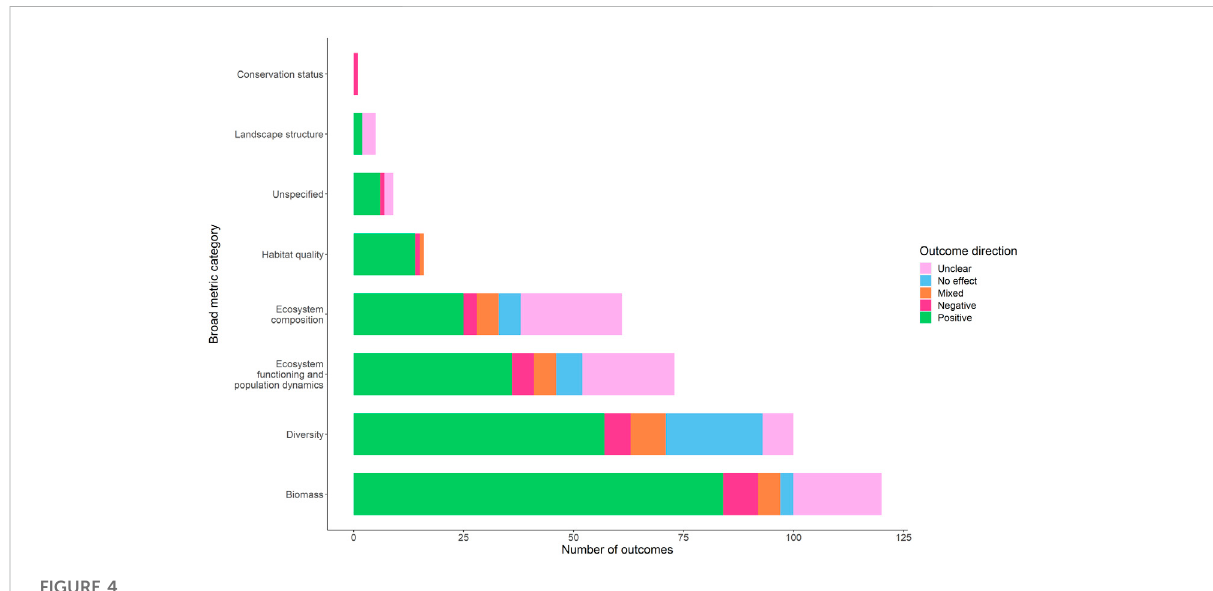
FIGURE 4 Outcomes nature-based interventions, across each of the eight broad categories of ecosystem health metrics. Outcome direction is colour